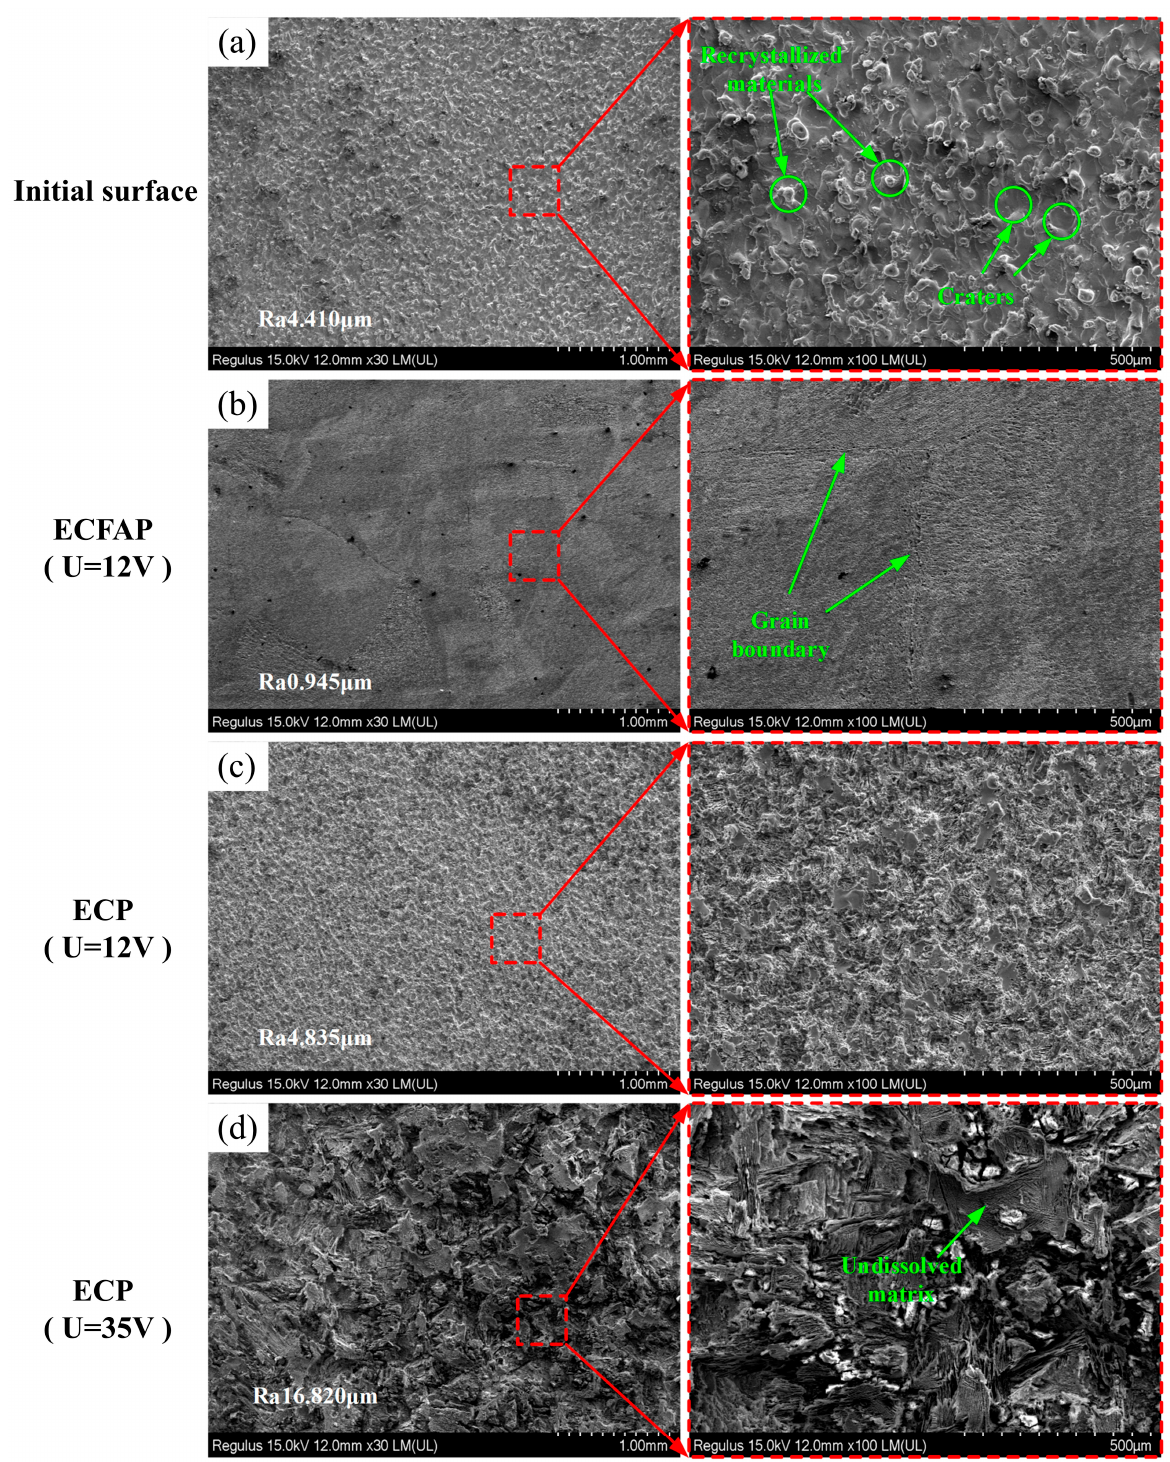
Figure 9. Comparison of surface finishing quality with and without treatment with abrasive parti- cles. ( a ) Initial surface; ( b ) ECFAP (U=12V); ( c ) ECP (U=12V); ECP (U=35V).